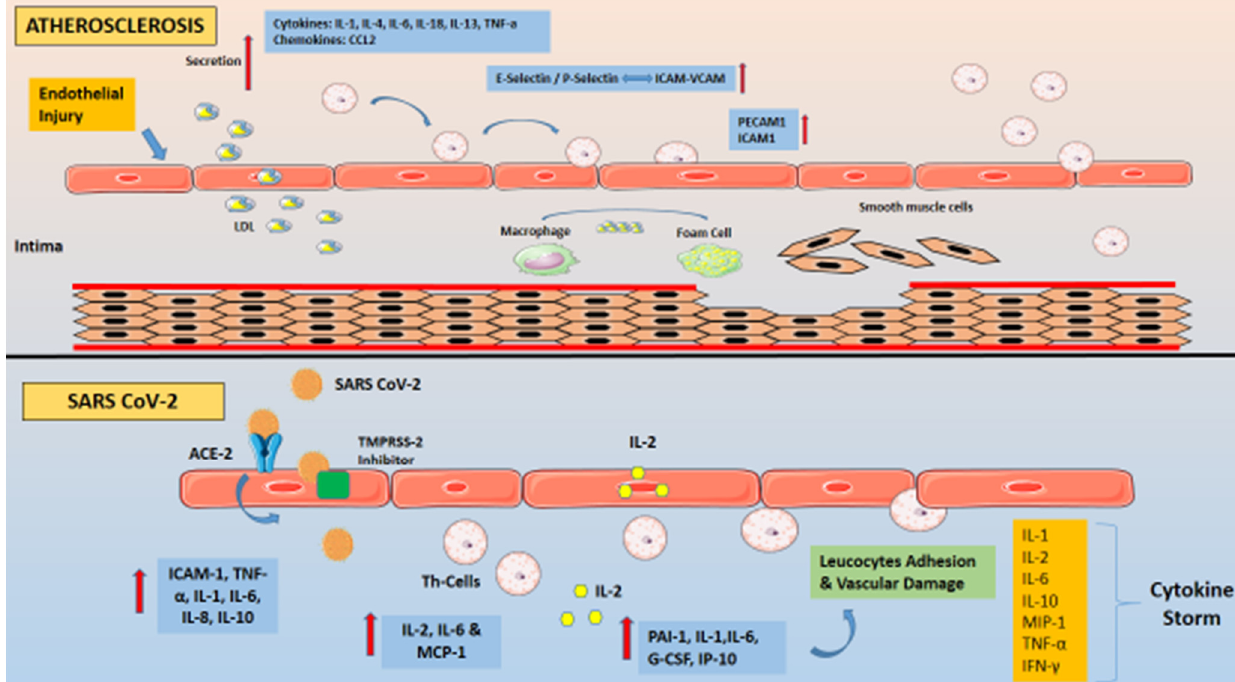
Figure 1. (i) Atherosclerosis: Involves the activation of the endothelium, which upregulates inflammatory signaling mechanisms via the release of inflammatory cytokines and chemokines. LDL particles accumulate in the tunica intima and are subjected to oxidative modification. Circulating monocytes bind to adhesion molecules expressed on the activated endothelial cell surface and migrate to the intimal layer. Subsequently, they transform to macrophages and express receptors that bind to oxidized LDL particles, ultimately turning into foam cells. T lymphocytes as well as vascular smooth muscle cells situated in the medial layer, also migrate to the intimal layer. (ii) COVID-19: “The role of endothelial cells in SARS-CoV-2 infection”. Severe acute respiratory syndrome coronavirus 2 (SARS-CoV-2) binds with Angiotensin-converting enzyme 2 (ACE2) on the cell membrane of the host cells. Cell invasion also depends on the presence of the protease Transmembrane protease serine 2 (TMPRSS-2) that can cleave the viral spike. The recombinant protein of human ACE2 fused with the Fc region of the human immunoglobulin IgG1 (rACE2-IgG1) binds with high affinity to the receptor-binding domain of SARS-CoV-2. In patients diagnosed with severe COVID-19, increased levels of pro-inflammatory cytokines, particularly the soluble interleukin 2-receptor (IL-2R) and interleukin-6 (IL-6), have been observed. Endothelial cells (ECs) express both the IL-6 receptor (IL-6R) and IL-2R on their surface. Soluble IL-2R (sIL-2R) is mostly secreted by activated T helper lymphocytes but might also be secreted by ECs. The binding of IL-6 and IL-2 on their receptors induces a capillary leak. Moreover, IL-6 signaling induces the secretion by ECs of more IL-6 and other cytokines. The continuous burdening of the endothelium leads to further secretion of inflammatory cytokines and the over-reaction of the immune system, the so-called “Cytokine Storm”. ΡΑΙ -1 = Plasminogen activator inhibitor-1, TNF = Tumor Necrosis Factor, ICAM = Intercellular Adhesion Molecule 1, VCAM = Vascular cell adhesion protein 1, PECAM = Platelet endothelial cell adhesion molecule-1, MCP-1 = monocyte chemoattractant protein-1, G-CSF = Granulocyte colony-stimulating factor, IP-10 = Interferon gamma-induced protein 10, MIP-1 = Macrophage inflammatory protein-1, IFN = Interferon.